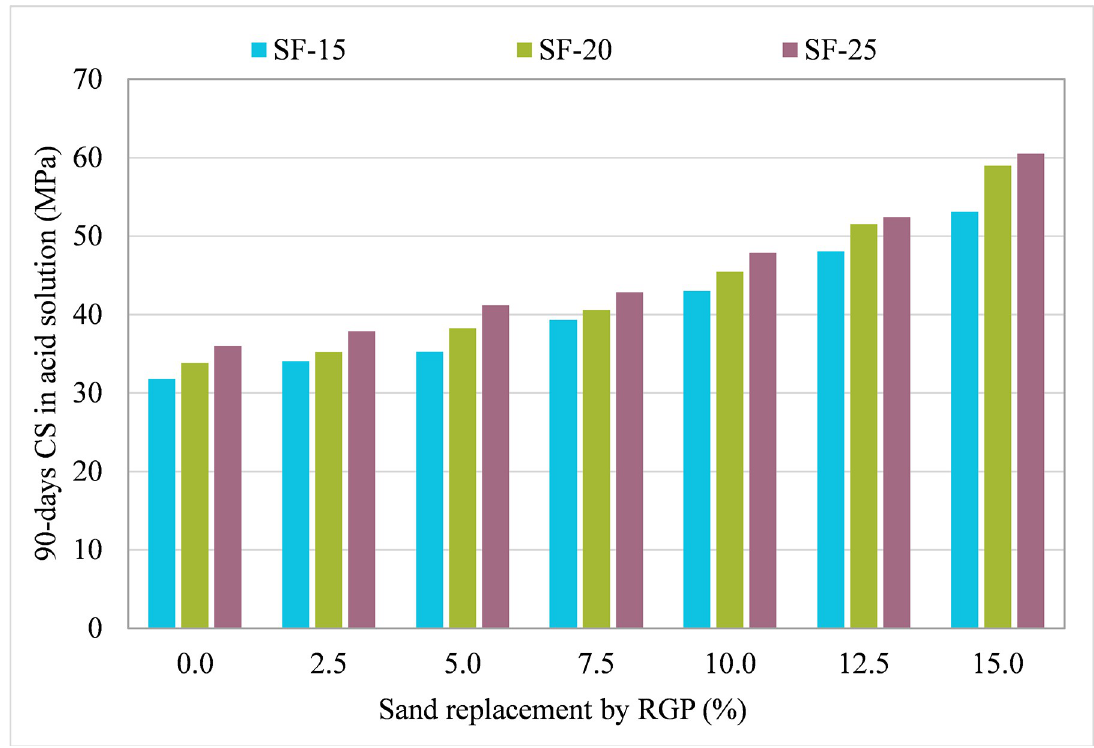
Fig 9. 90-day CS of samples incorporating RGP as a sand replacement after subjected to the acid solution.